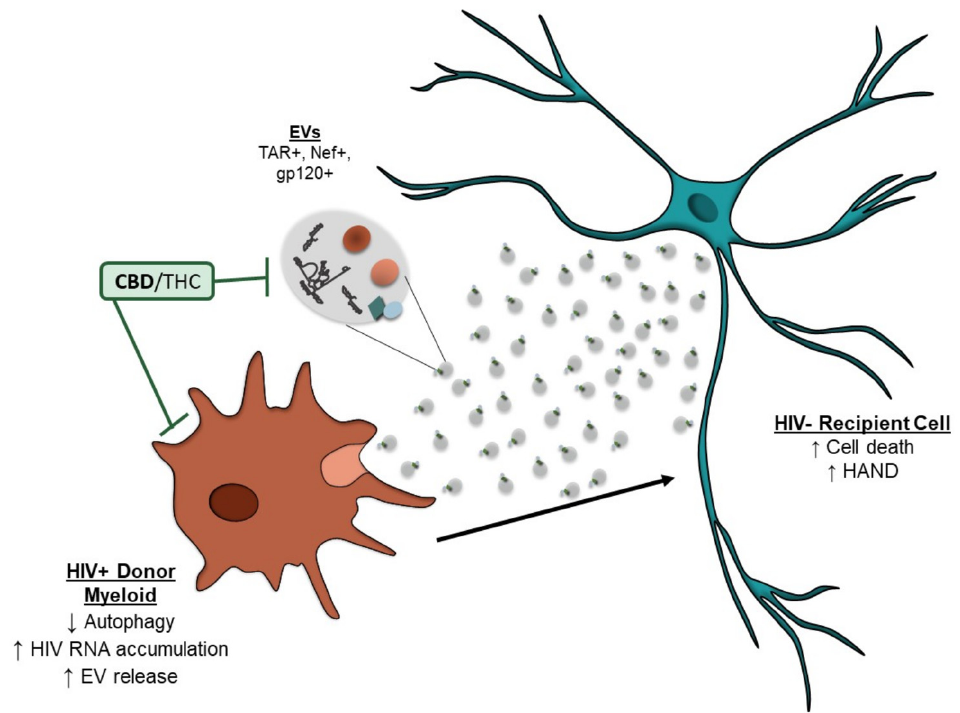
Figure 7. Summary of effects of cannabinoids on HIV-1 infected myeloid cells and their EVs. HIV-1 infected myeloid cells, even in the presence of cART, can transcribe viral RNAs that can be made into proteins. HIV proteins or potentially RNA can alter the autophagy pathway, resulting in the accumulation of viral products in the cytosol. This can induce increased secretion of EVs carrying viral RNAs and proteins, which can potentially contribute to the neuroinflammation seen in HAND and neuronal cell death. Cannabinoids, CBD can inhibit the abundance of EVs secreted from HIV- 1 infected myeloid cells, as well as the viral RNA and protein cargo incorporated inside the EVs potentially through inhibition of intracellular transcription processes and restoration of the autophagy pathway. This can contribute to decreased EV-mediated inflammation and cellular